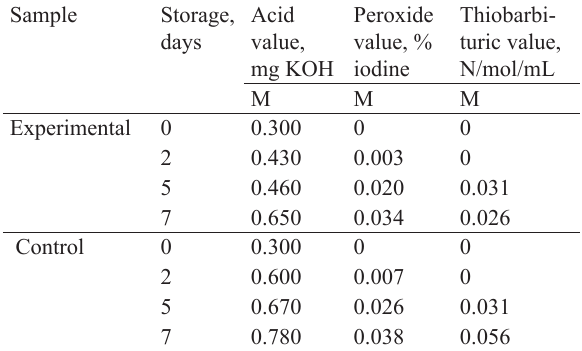
Table 12 Changes in lipid fraction of pork packed in biodegradable film based on